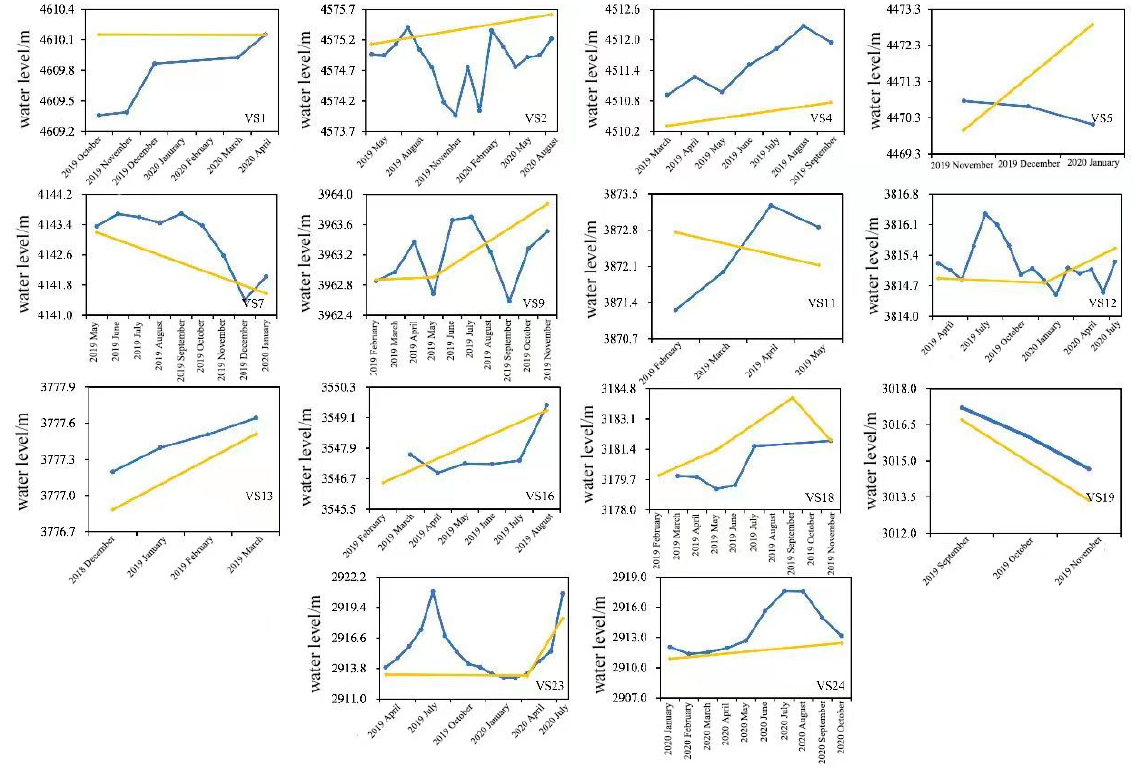
Figure 9. ICESat-2 and Hydroweb river water levels for